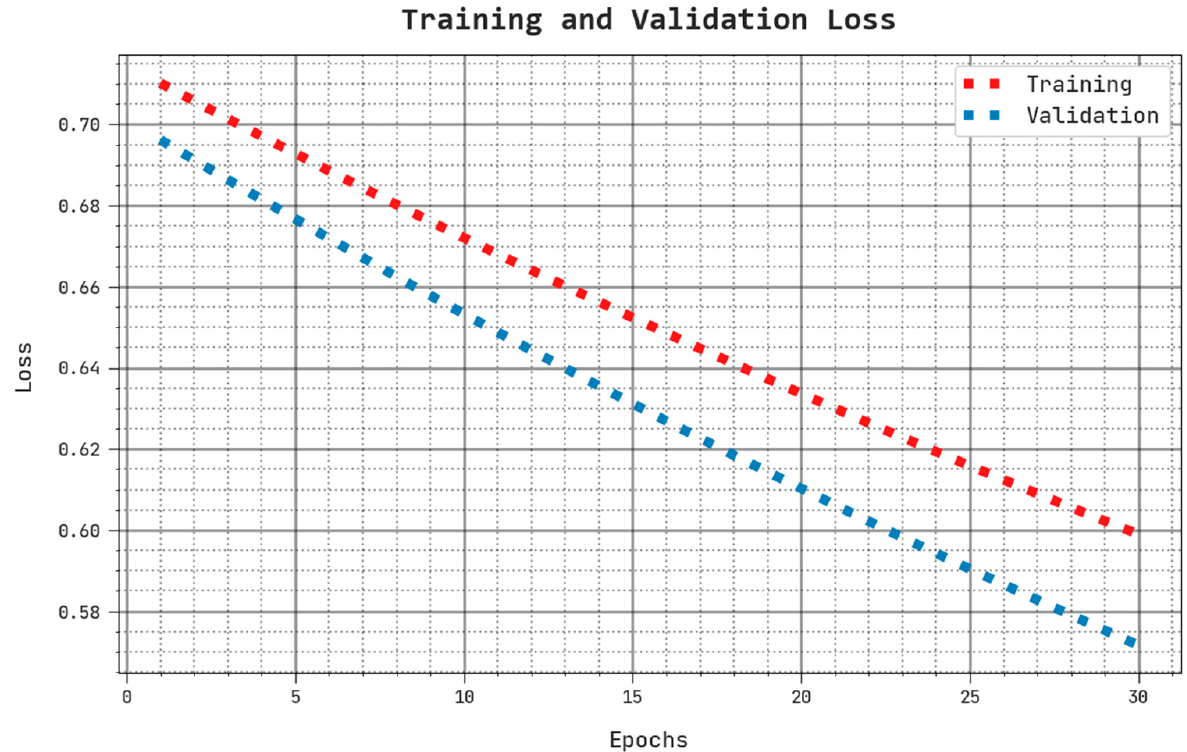
Figure 8. TACC and VACC analysis of AHBATL-MNC approach.